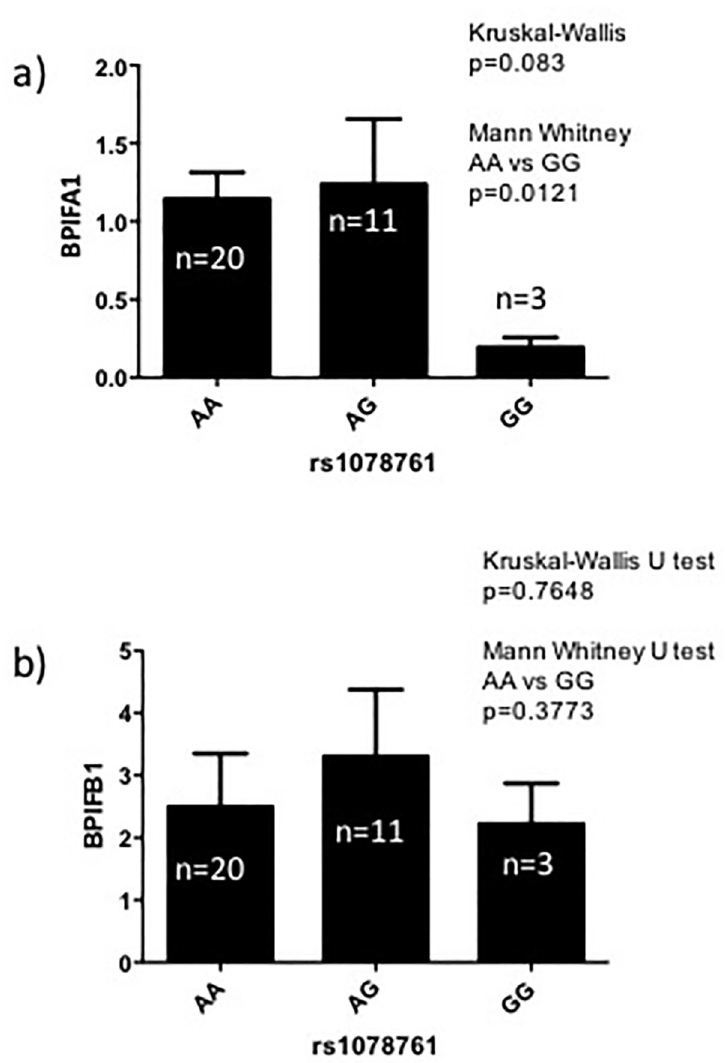
Fig 2. Association between rs1078761 genotype and BPIFA1 levels in the saliva of clinically stable patients with CF. The y axis shows P values in the–log 10 scale for polymorphisms that were tested for association in the meta- analysis of 6365 CF patients for lung disease severity. rs1078761 remained the most significant association in the region (purple diamond). The extent of linkage disequilibrium (measured by the r 2 statistic) with rs1078761 for the remaining SNPs is indicated with